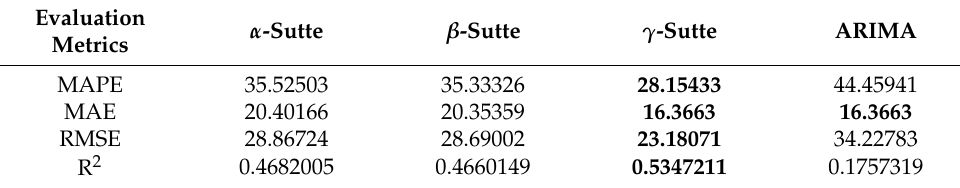
Figure 3. Five-year prediction chart of No. 6 Naphtha Cracking Complex regions. ( a ) Time series model; ( b ) Ensemble model. Table 3. Prediction results of the time series model in No. 6 Naphtha Cracking Complex region.